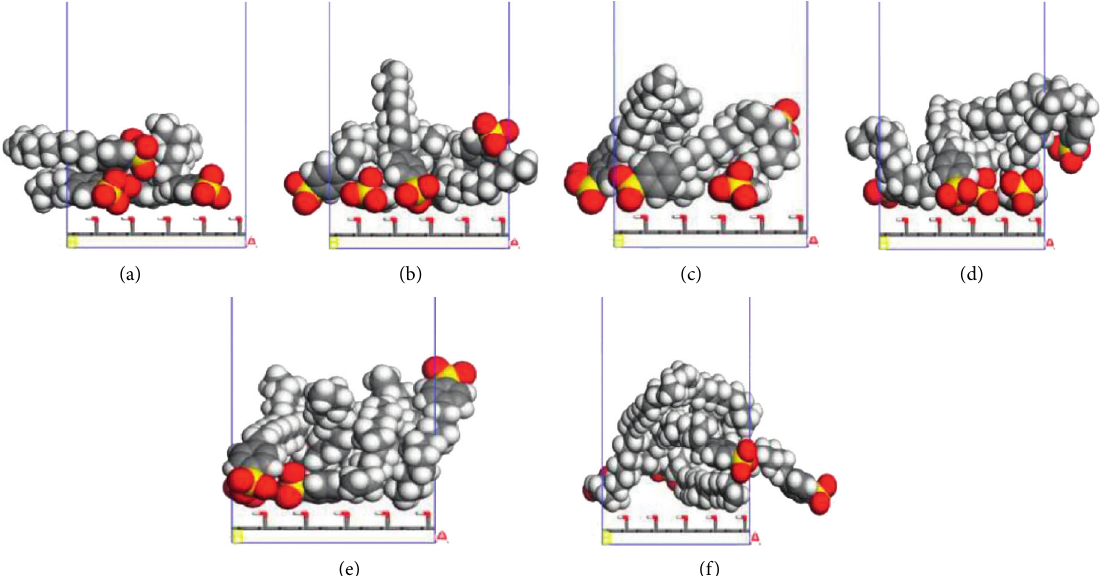
Figure 6: The final configuration of different systems adsorbed near the hydroxyl group: (a) C8; (b) C10; (c) C12; (d) C14; (e) C16; (f)